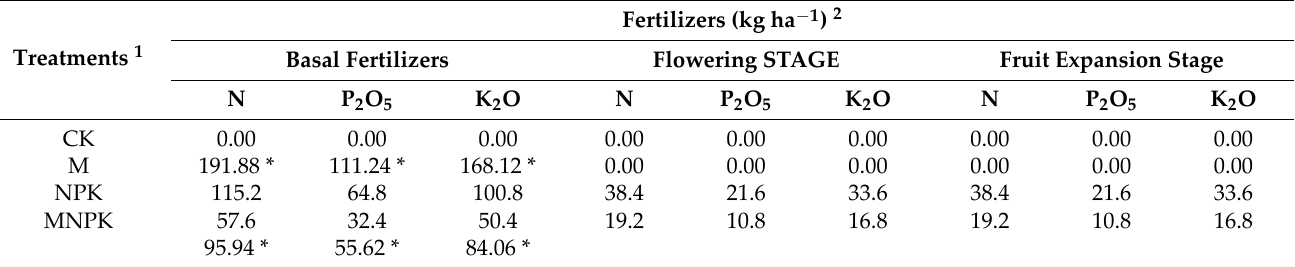
Table 2. Fertilization schemes under different